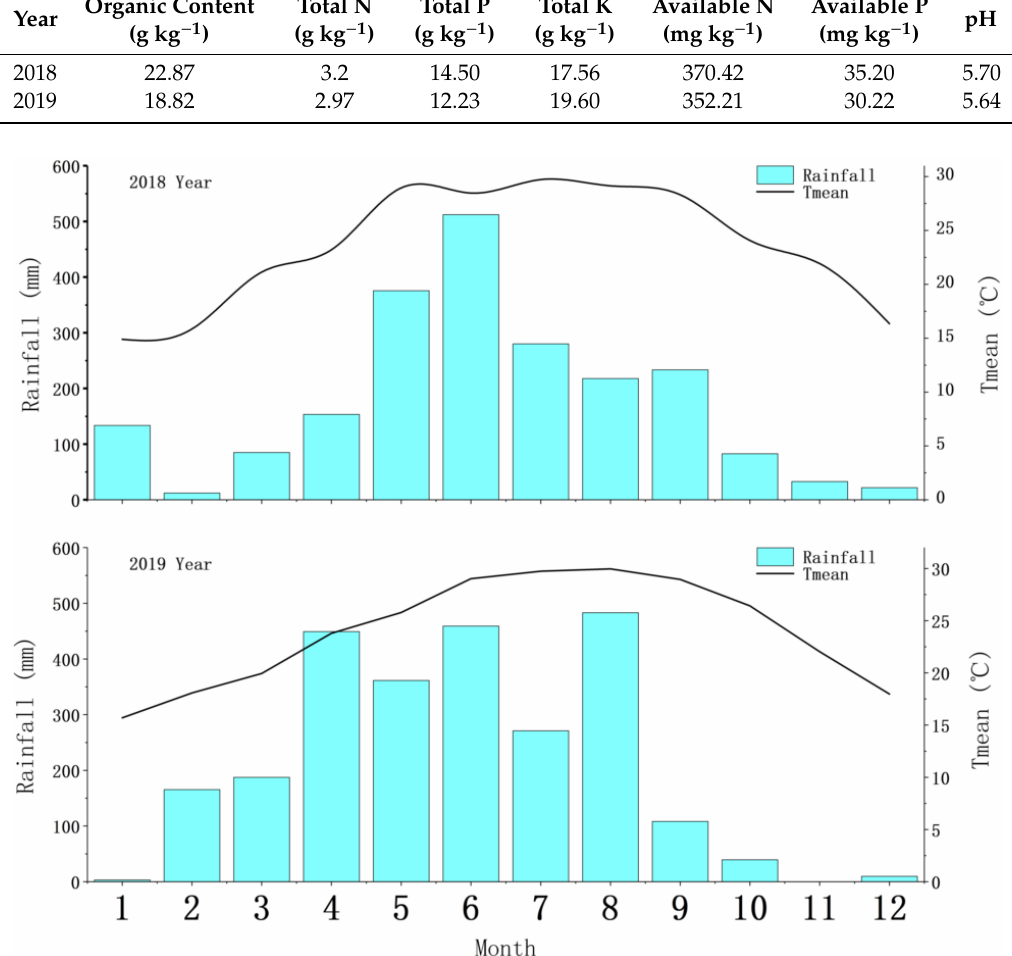
Figure 1. Temperature and rainfall during the experiment.